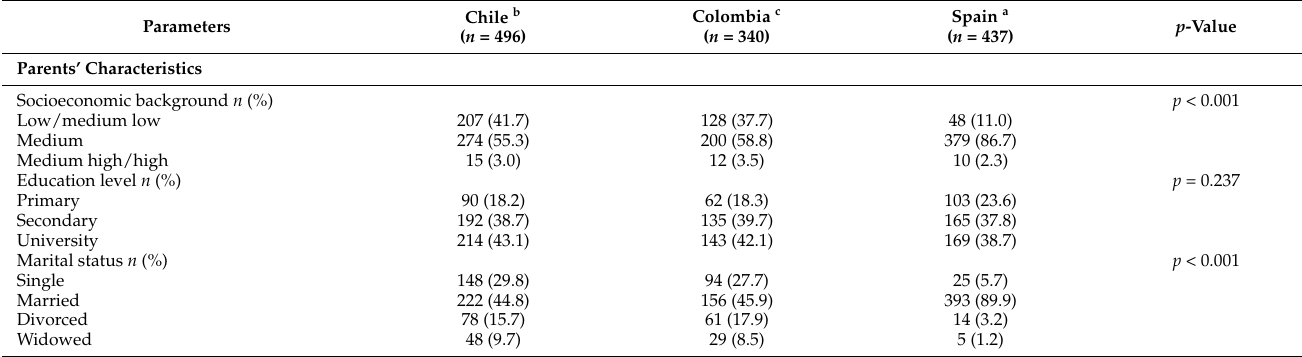
Table 2. Parents’ sociodemographic characteristics of study sample according to country.